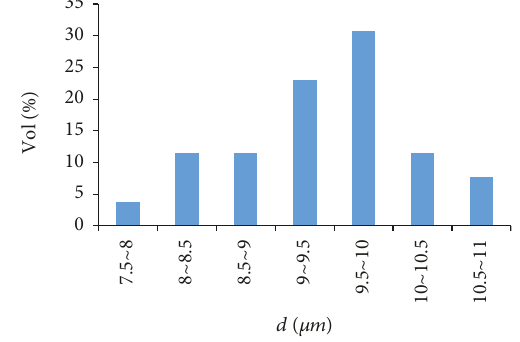
Figure 6: Fiber diameter